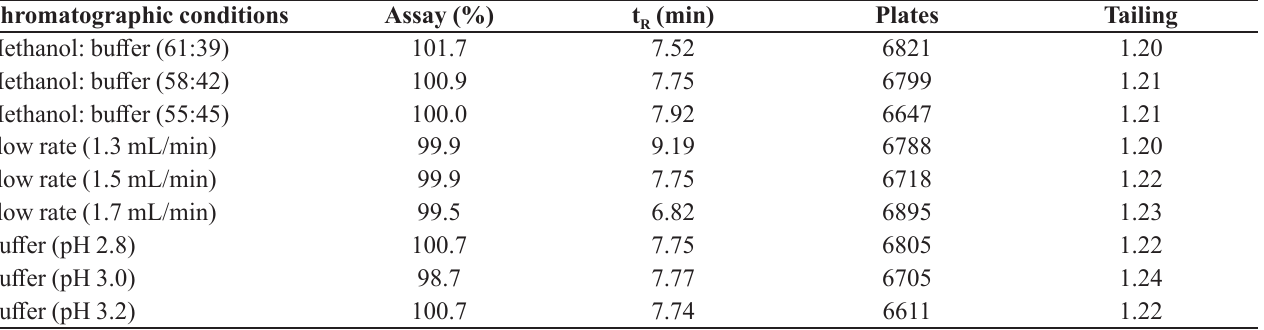
TABLE IV - Robustness study of Dexamethasone Chromatographic conditions Plates Tailing